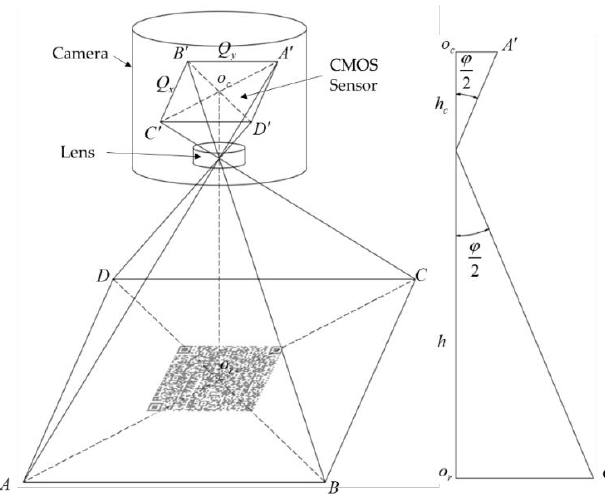
Figure 8. Simplified camera image acquisition model.